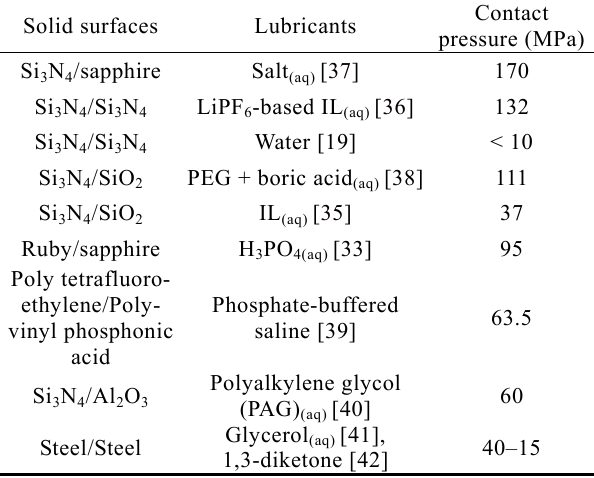
Table 1 Liquid superlubricity systems with different sliding solid surfaces, lubricants, and final contact pressures (MPa) in superlubricity state.